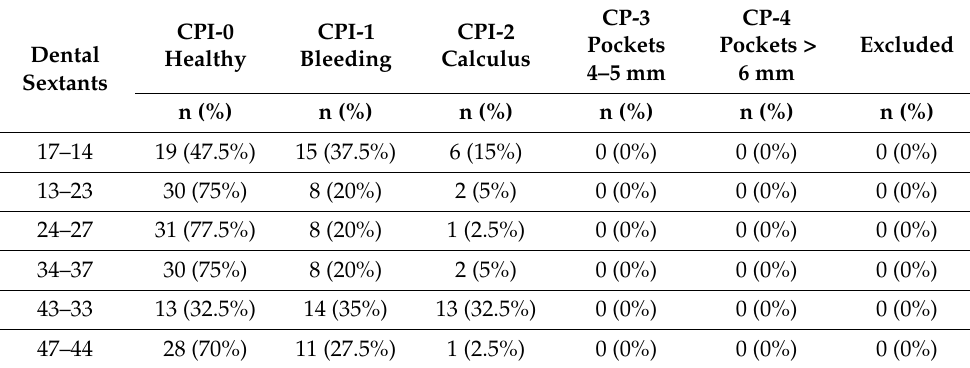
Table 3. An analysis of periodontal health based on the CPITN index—control group.